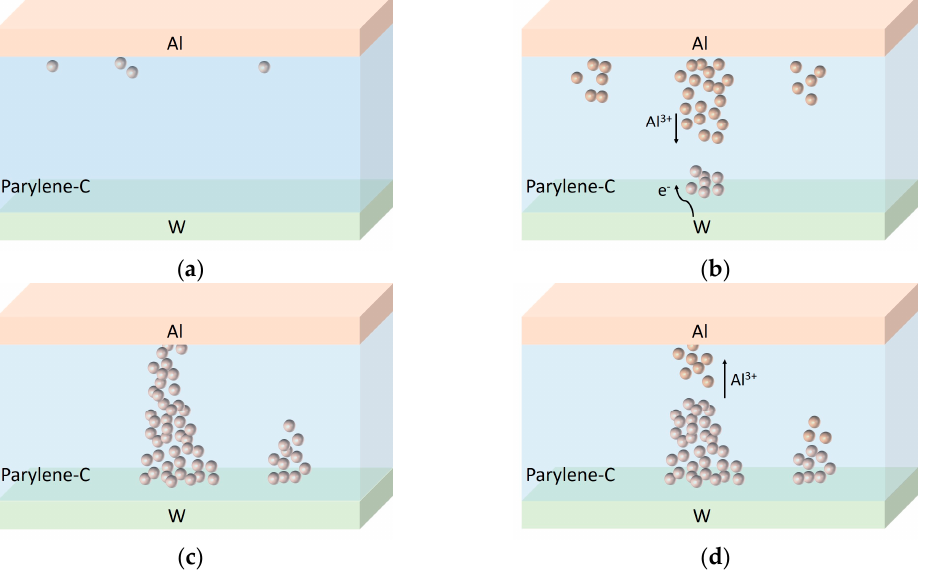
Figure 4. Schematic diagram of switching mechanism explaining the operation of the Al/polychloro- para-xylylene (parylene-C)/W device; ( a ) Initial low current state of the as-fabricated device; ( b ) Oxidation of Al at the top electrode, the migration of the Al ions into the parylene-C and the reduction of Al ions at the bottom electrode; ( c ) Formation of an Al conductive filament connecting the top and bottom electrodes; ( d ) Dissolution of the Al conductive filament at the weakest position of the filamentary path.